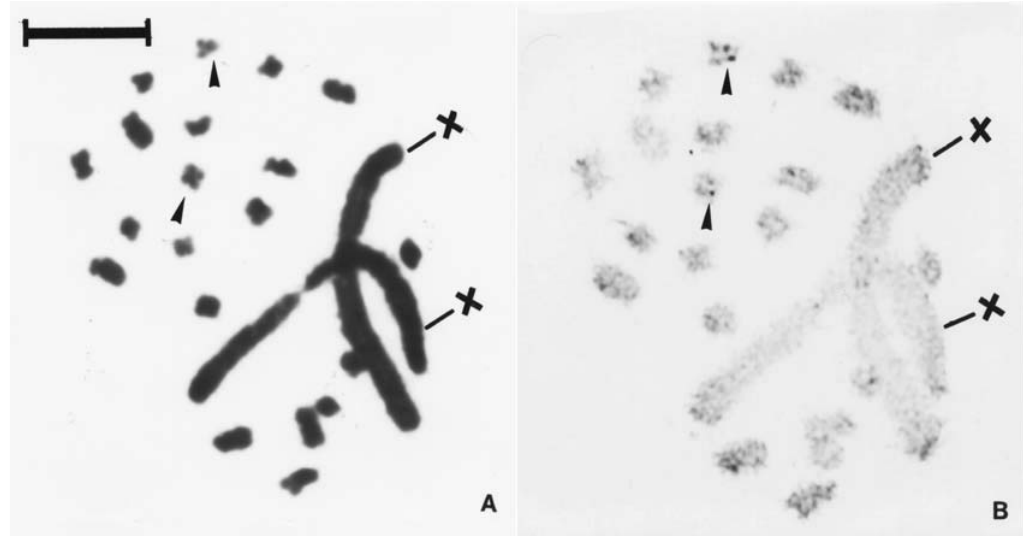
Figure4 -Adult Paranaitaopima oogonialmetaphasewith2n=22(20+XX).A.Giemsastaining,showingchromosomalelementsofpair6(arrowhead). B. The same cell as shown in A, with Giemsa and Ag-NOR sequential staining showing NORs on pair 6 (arrowhead). Bar = 10 (cid:2) m.